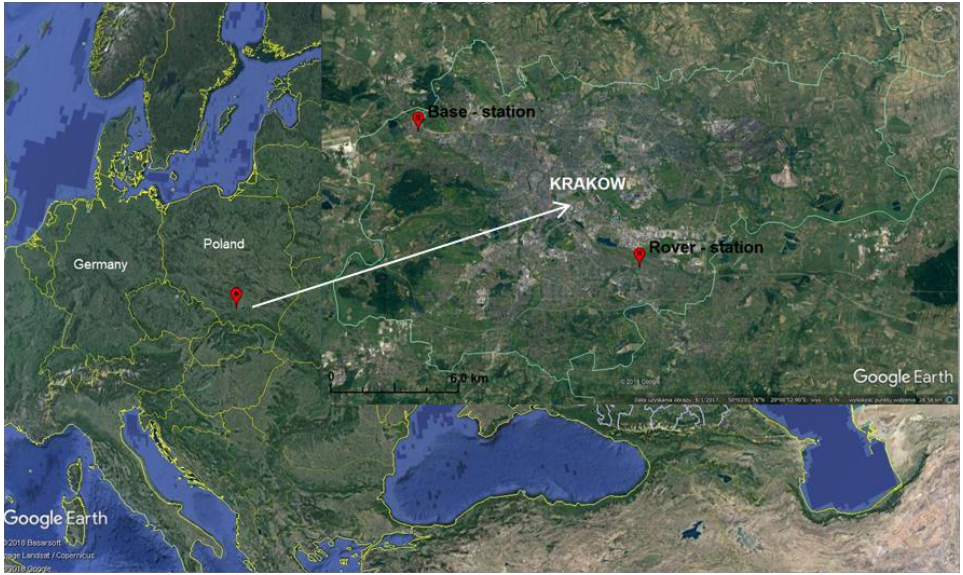
Figure 4. Location of the research facility (Base-station and Rover-station). Source: own calculation based on GoogleEarth.